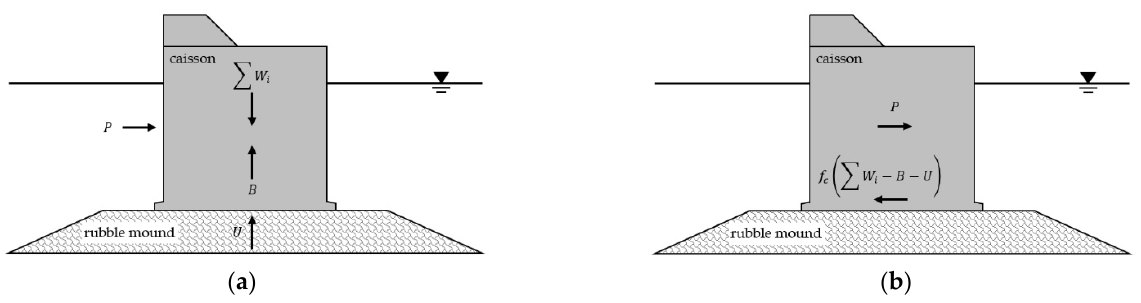
Figure 1. Caisson and force equilibrium: ( a ) component forces; and ( b ) load and resistance force.